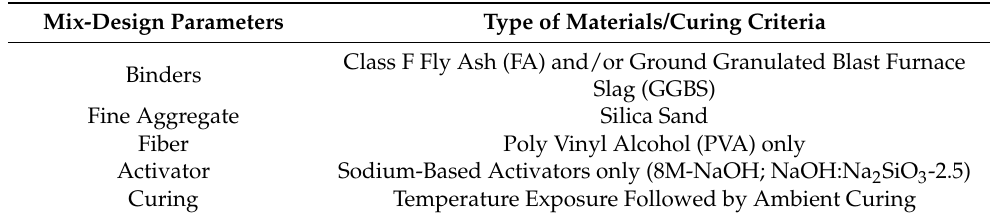
Table 1. Mix-design parameters, types of materials/criteria adopted in this research.